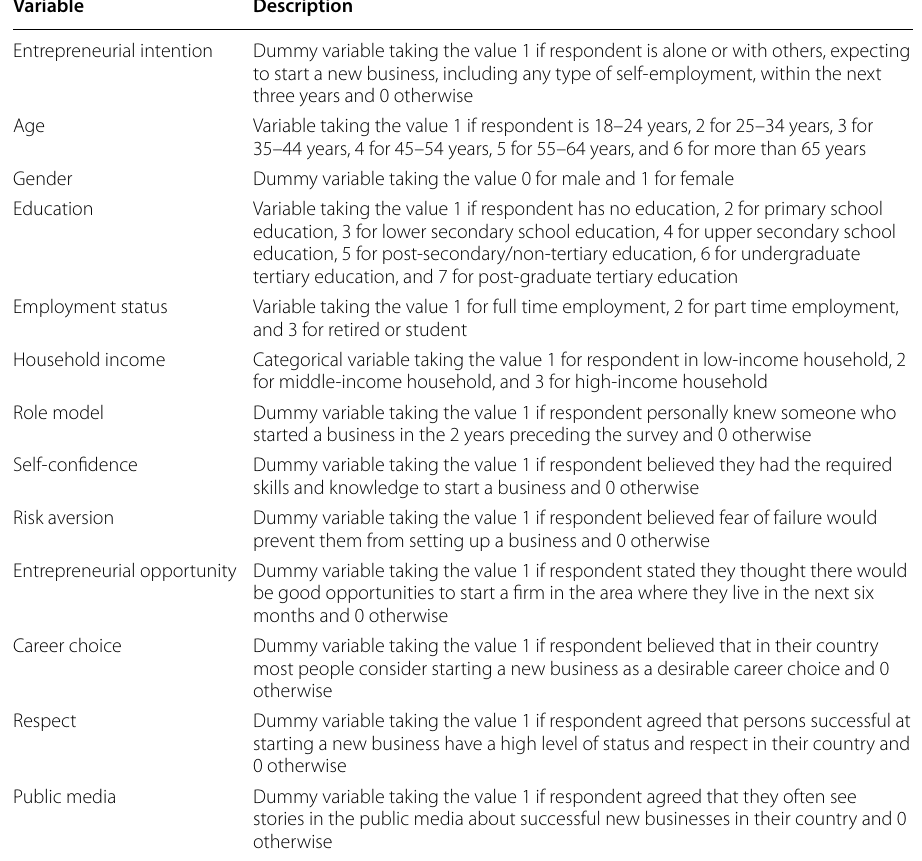
Table 1 Description of